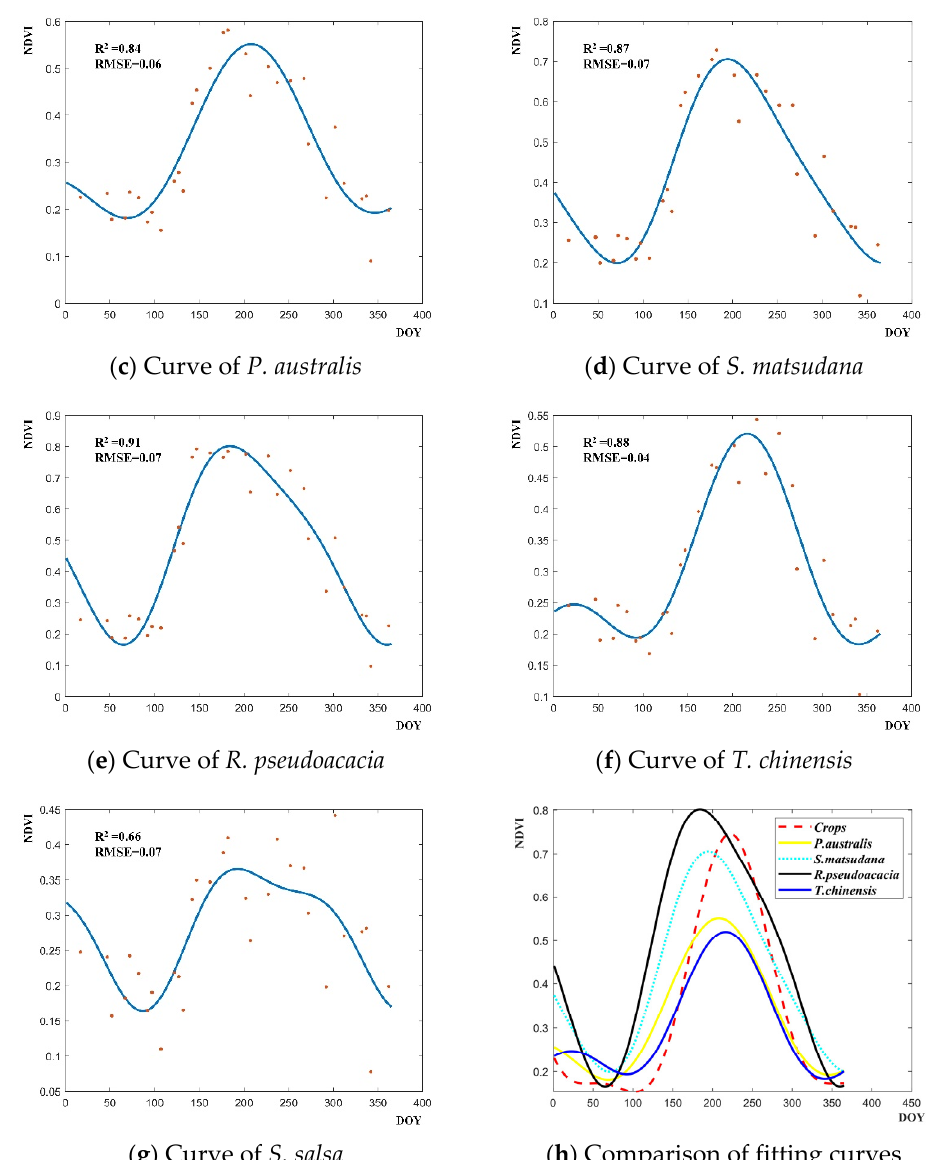
( g ) Curve of S. salsa ( h ) Comparison of fitting curves Figure 12. Fitting curve of wetland vegetation. Figure 12. Fitting curve of wetland